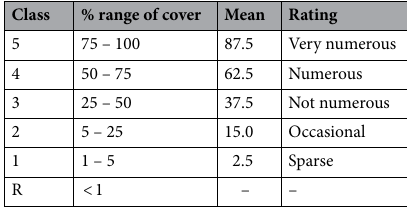
Table 1. Braun-Blanquet rating scheme for vegetation cover-abundance, Source 19